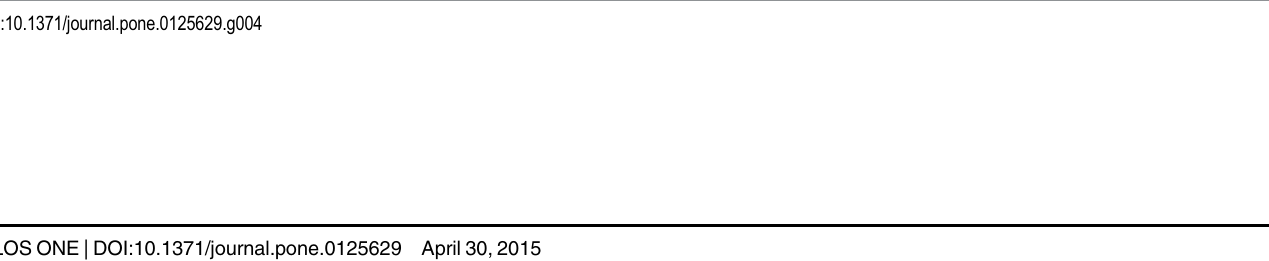
PLOS ONE | DOI:10.1371/journal.pone.0125629 April 30,